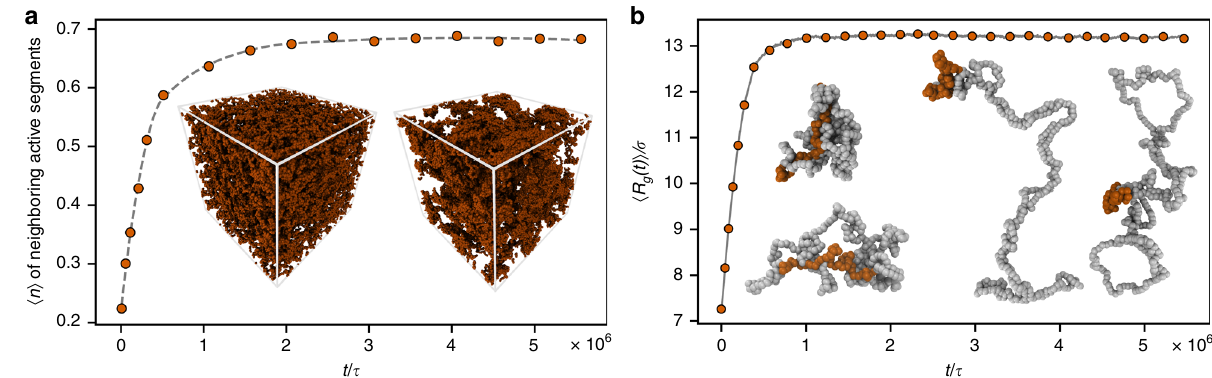
Fig. 1 Structural properties of the system as a function of time after the onset of activity. a Mean number of neighboring hot segment as a function of time. Two hot segments are neighboring if their centers of mass are within the distance of their radius of gyration (3 : 25 σ ). A completely uniform distribution corresponds to a value 0 : 3. The dashed gray line is a guide to the eye. Insets: snapshots of the system showing only the hot segments at an i obtained as an average over all rings at a given time t after the onset of activity early (left) and a late (right) time. b The mean radius of gyration h R g (Eq. (4) in Methods). Insets: snapshots of two rings in equilibrium (left) and two at late times (right). The hot segment on the active rings is shown in orange (on the equilibrium rings the orange segment is highlighted for comparison only and has the same temperature as the rest of the system).